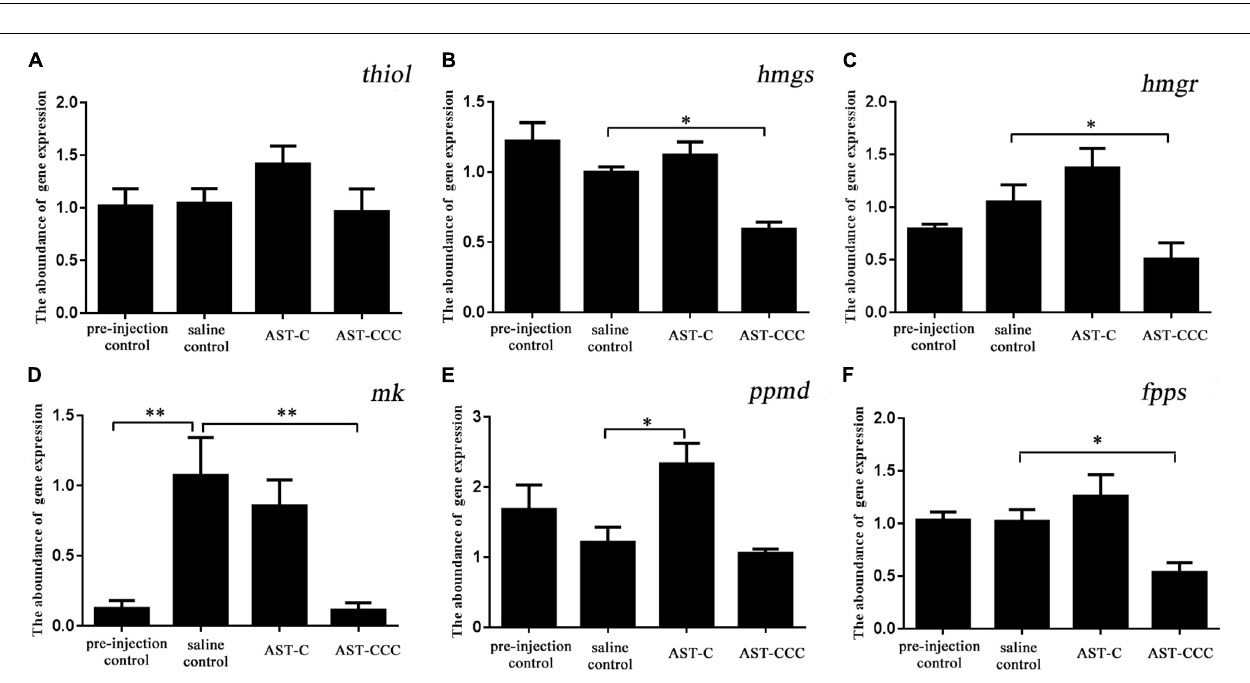
FIGURE 6 | In vitro effects of Scypa AST-C and Scypa AST-CCC peptides on the abundance of 20E biosynthetic enzyme gene expression in the Y-organ. (A) The abundance of disembodied gene expression in Y-organ; (B) the abundance of shadow gene expression in Y-organ. Data were shown as means ± SEM ( n = 5). No significant change in the abundance of disembodied and shadow expression in the Y-organ was detected after addition of Scypa AST-C or Scypa AST-CCC peptide.